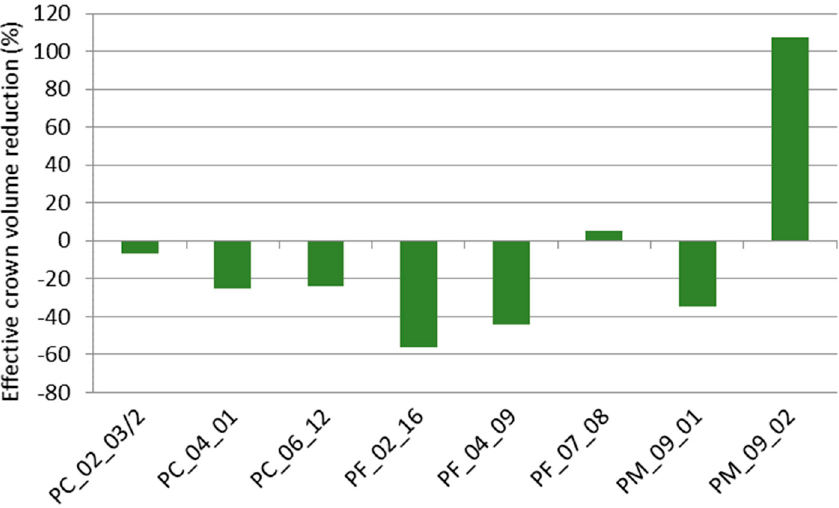
Figure 2. Effective crown volume reduction of investigated ‘Summit’ cherry trees grafted on different size-controlling rootstocks ( Prunus cerasus —PC, Prunus fruticosa —PF, Prunus mahaleb —PM) in relation to ‘Gisela 5 ′ considered as zero.